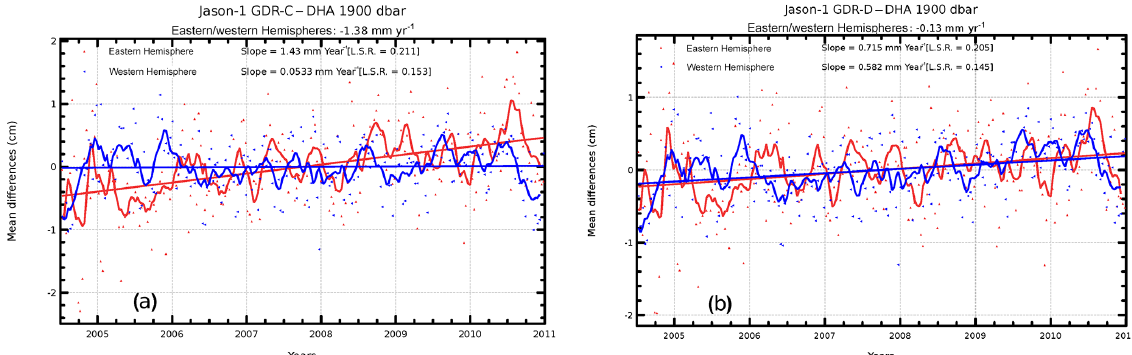
Figure 8. SSH differences (cm) between Jason-1 altimeter data and Argo (1900dbar) in situ measurements computed with GDR-C (a) and CNES preliminary GDR-D orbit solutions (b) , separating east (<180 ◦ , in red) and west (>180 ◦ , in blue) longitudes. Corresponding annual and semi-annual signals are removed. Trends of raw data are indicated and the 2-month filtered signal is added.